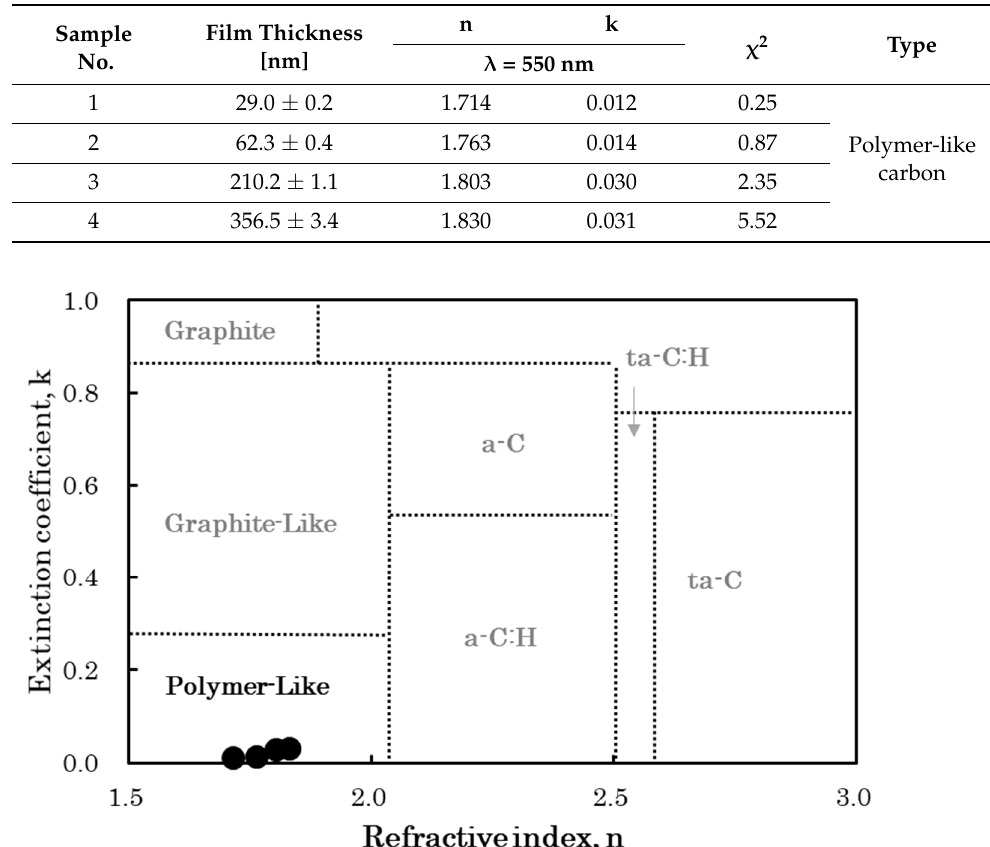
Figure 1. DLC film types based on n–k plots [7,19].